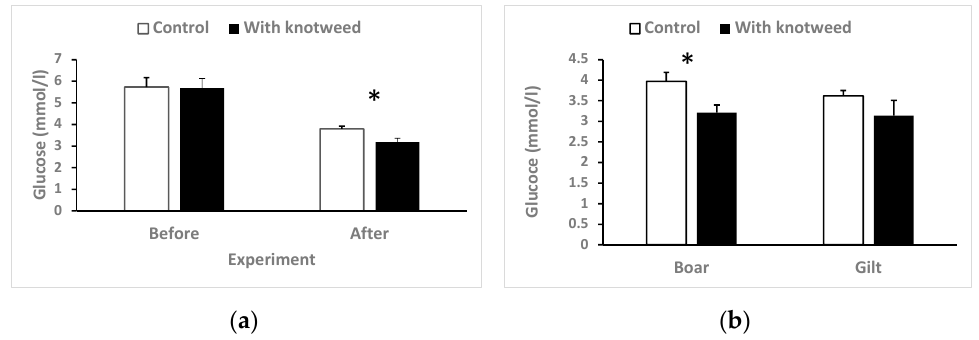
Figure 9. Serum glucose in all animals at the beginning and the end of the experiment ( a ) and according to the sex ( b ) in the tested group of pigs and the control group of pigs at the end of the experiment. Means + SEM. Difference significant on p < 0.05 marked by an asterisk.